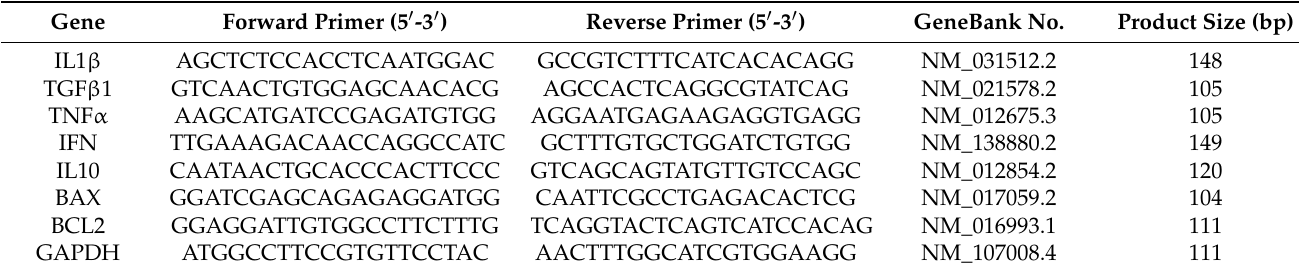
Table 2. Details for the primer sequences used in RT-PCR analysis of inflammation- and apoptosis- related